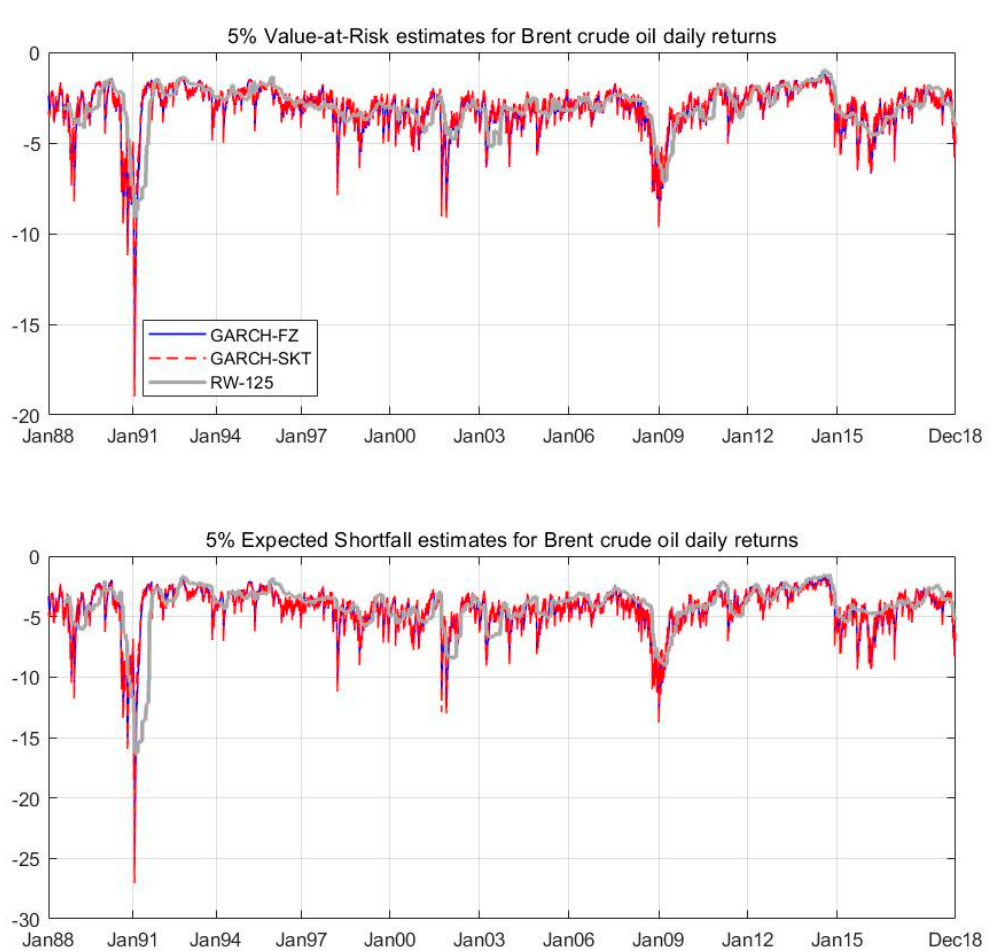
Figure 3. The estimated 5% VaR and ES values for the daily returns on the Brent crude oil price for the period of January 1988 to December 2018. The estimates were based on a one-factor GAS model, a GARCH model, and a rolling-window model, using 125